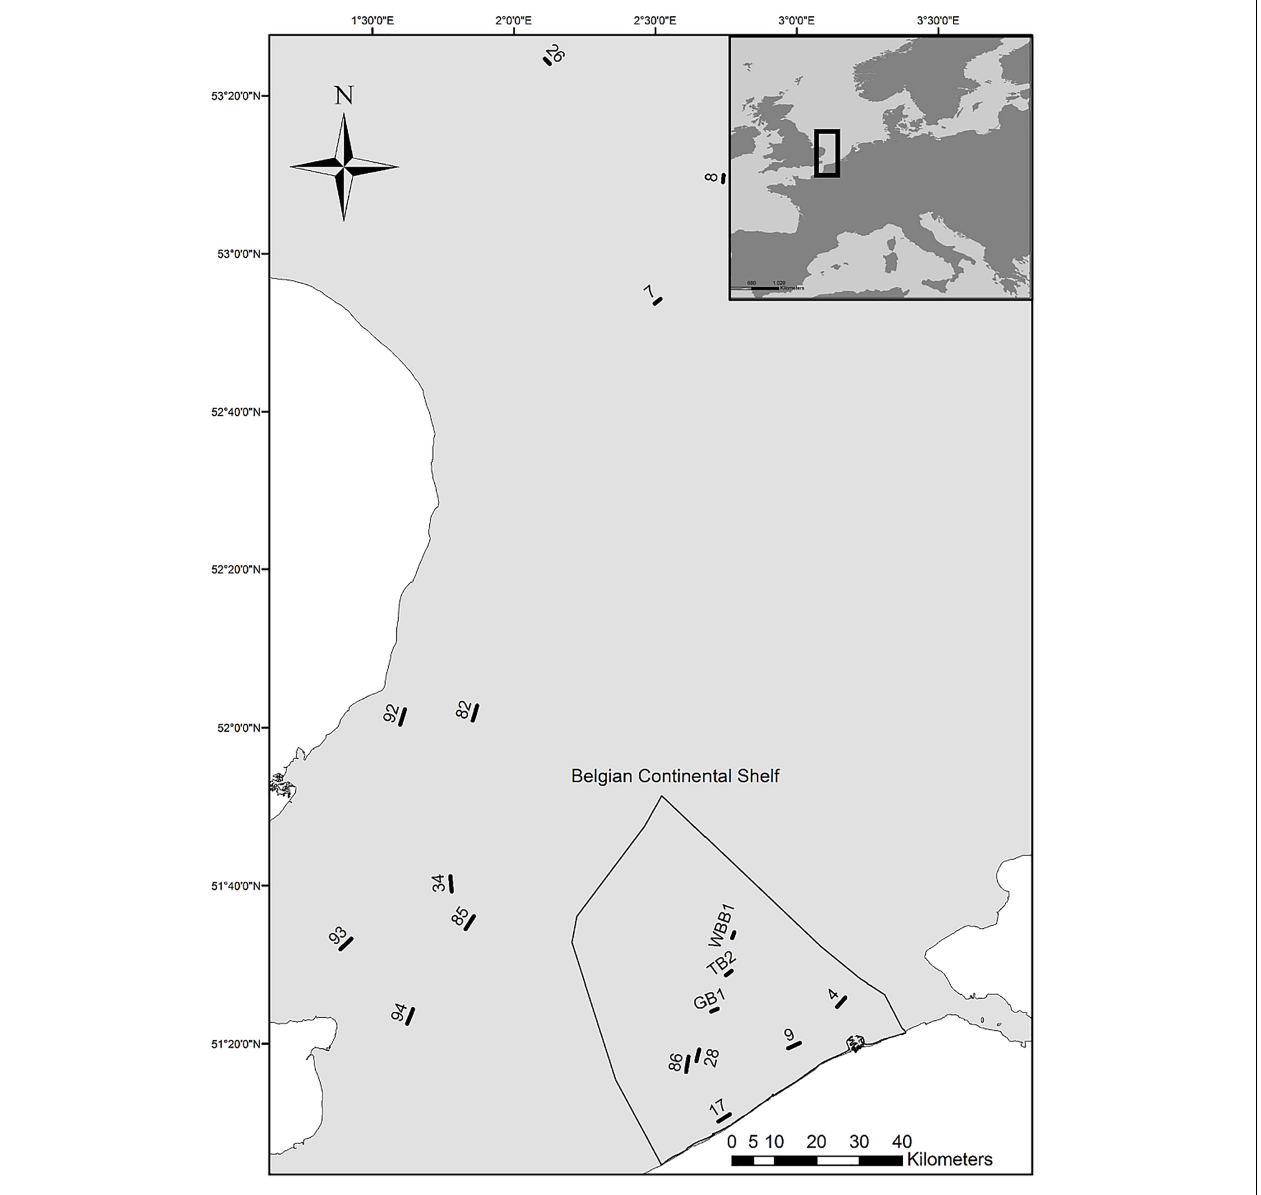
FIGURE 2 | Overview of fish sampling locations at the Southern part of the North Sea. Locations BPNS: 4, 9, 17, 28, 86, TB01, GB01, WBB01; locations UKNS: 34, 82, 85, 92, 93, 94; locations OFFNS: 7, 8,